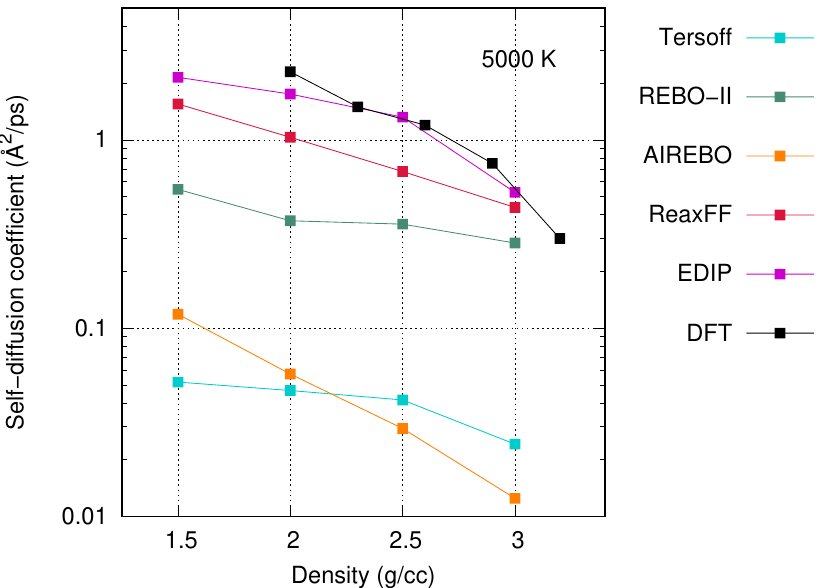
Figure 7. Self-diffusion coefficient at 5000 K as a function of density for all five potentials and DFT. The methodology employed for the DFT data is described in Ref.